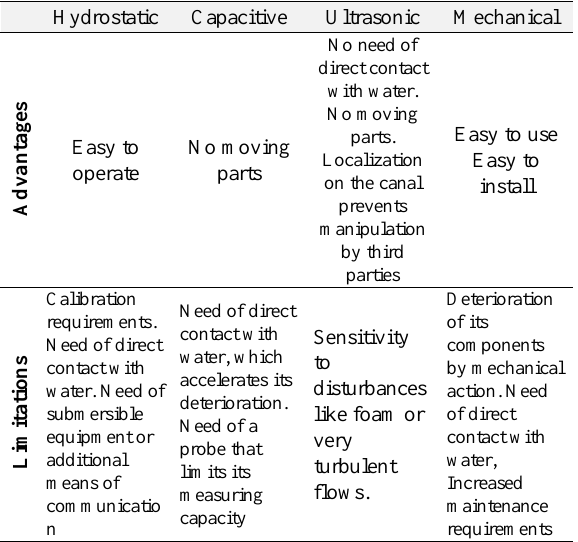
Table 1. Technologies for level measurement